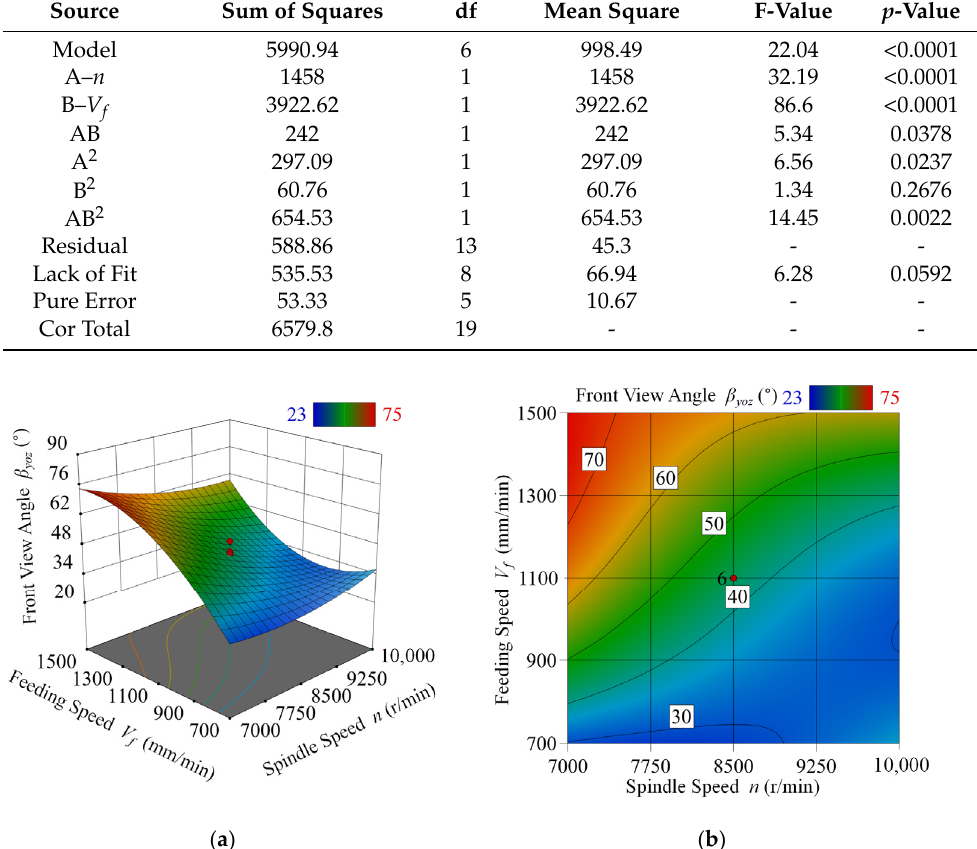
Table 4. The ANOVA results for the orthogonal diffusion angle β yoz are as follows: R 2 = 0.9105; adjusted R 2 = 0.8692; predicted R 2 = 0.7014; adeq precision = 15.6975. Notably, the overall model